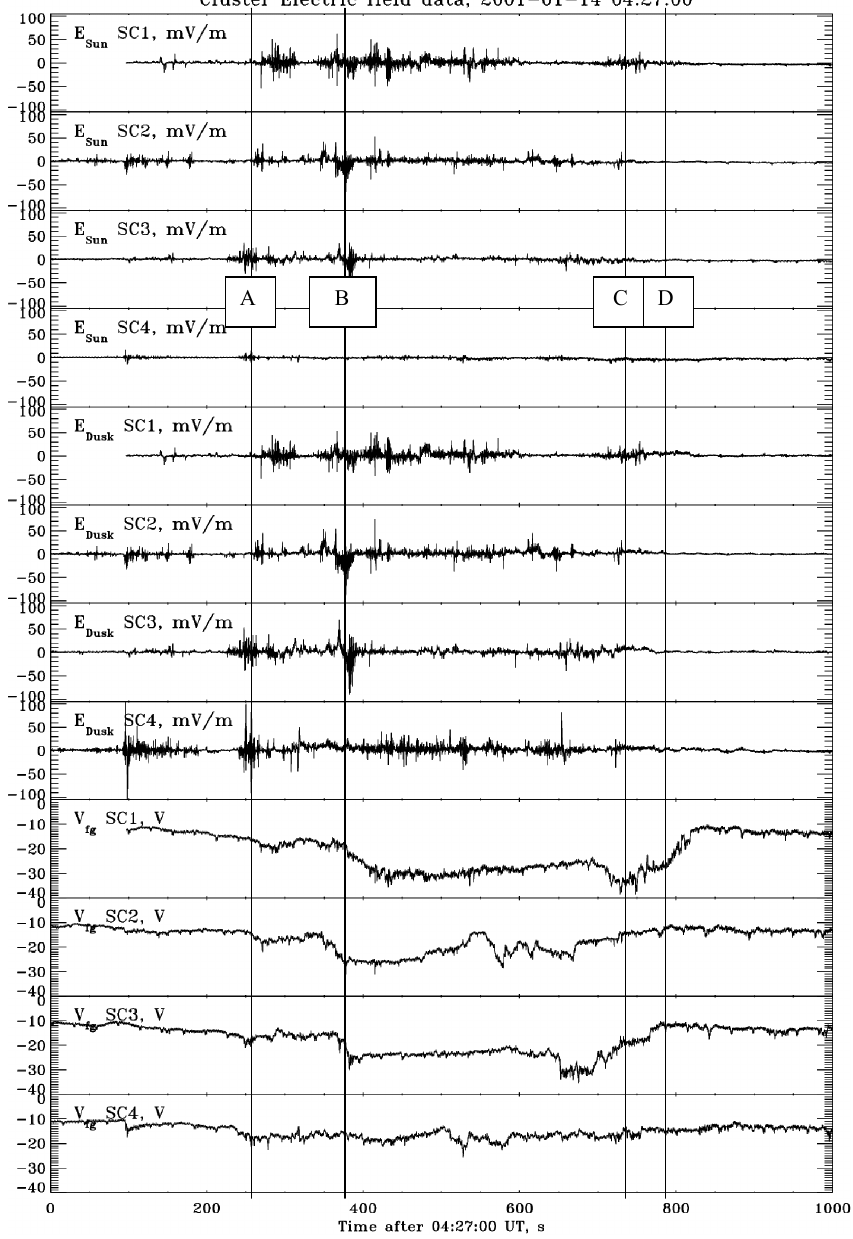
Fig. 7. Electric field and satellite potential data from near-perigee auroral field line crossings by the four Cluster spacecraft on 14 January 2001. The time axis is seconds relative to 04:27 UT on spacecraft 3, while the time axes for the other spacecraft have been shifted. The vertical lines A–D at 260, 375, 730 and 780 s, respectively, are included to facilitate the location of regions described in the